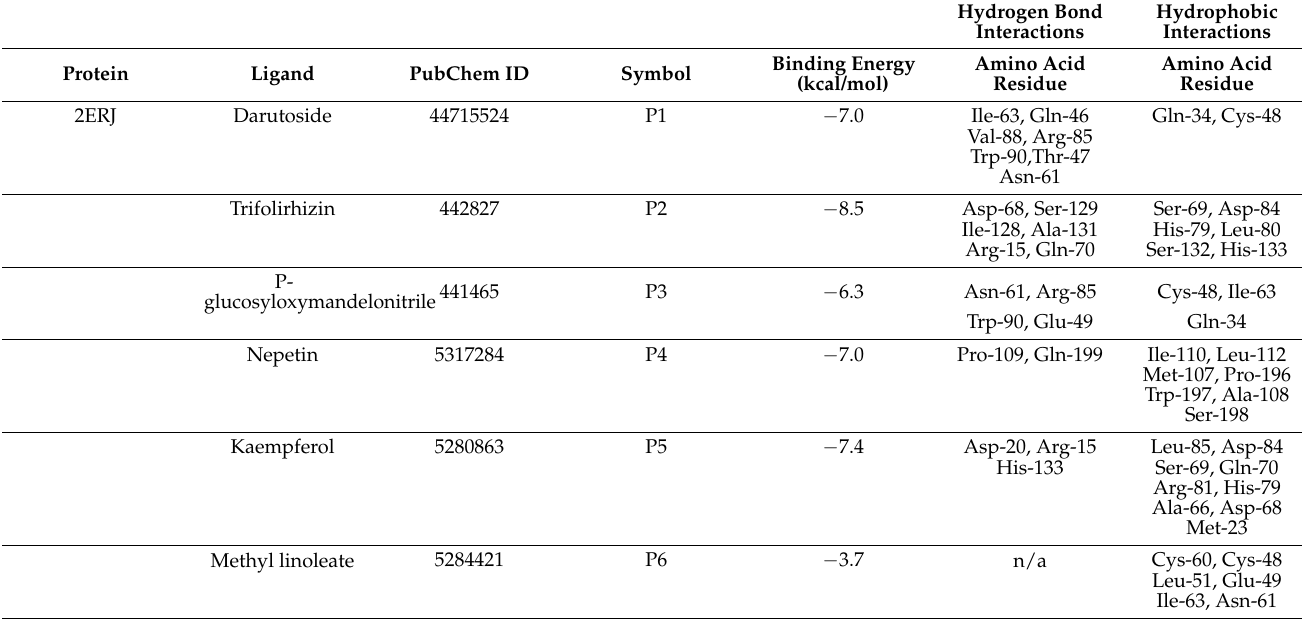
Table 8. Binding energy of potential active compounds on IL2 (PDB ID: 2ERJ).